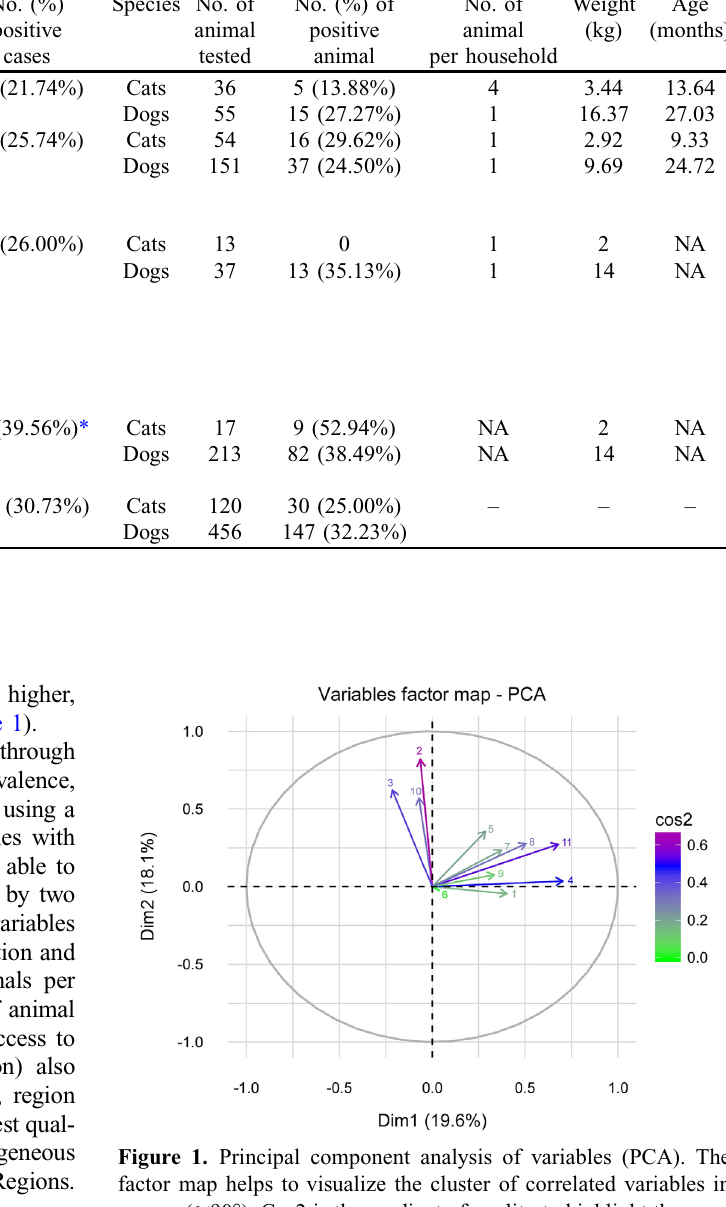
Table 1. Prevalence and surveyed data for Toxoplasma gondii in studied regions. Regions